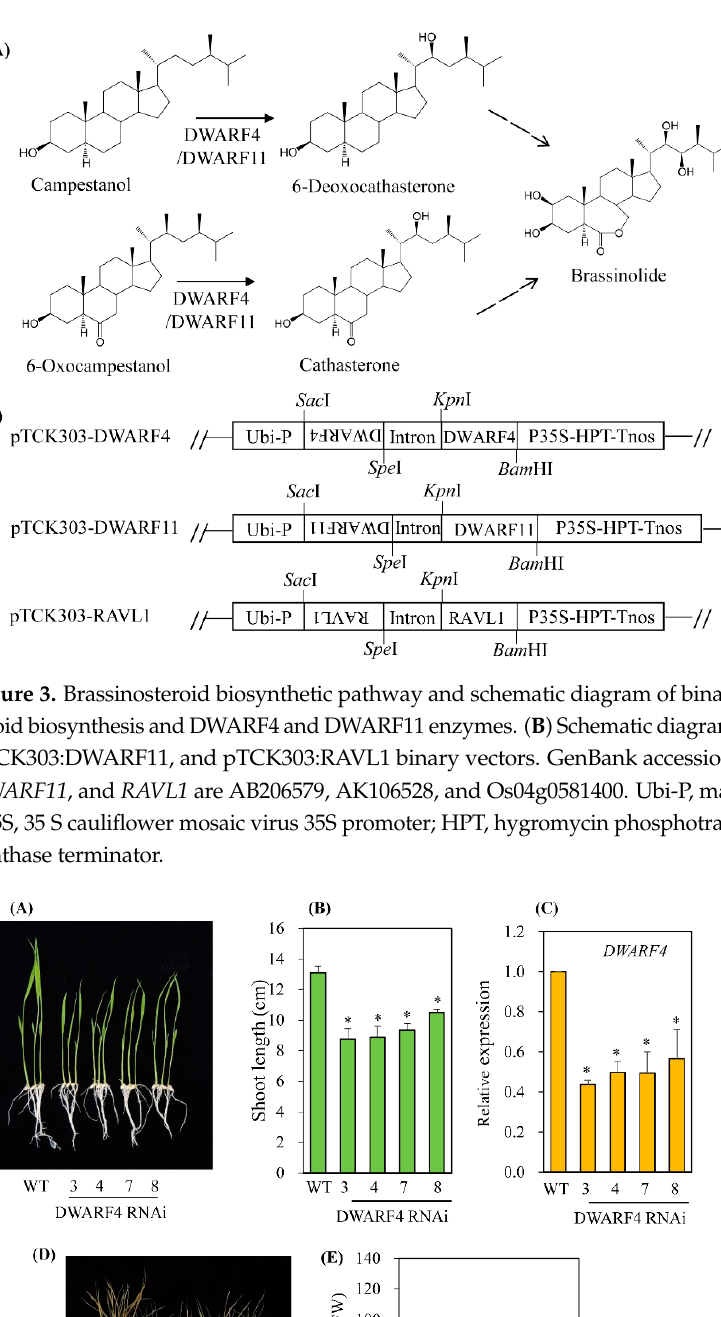
Figure 5. Generation of DWARF11- suppressed transgenic rice plants. ( A ) Phenotypes of 7-day-old wild- type (WT) and DWARF11 RNAi transgenic (T 2 ) rice seedlings. ( B ) Shoot length measurement. ( C ) Results of qRT-PCR analyses of WT and transgenic (T 2 ) lines. ( D ) Phenotypes of 7-day-old rice seedlings after cadmium treatment. ( E ) Melatonin levels of WT and transgenic lines. The 7-day-old rice seedlings were challenged with 0.5 mM cadmium for 3 days for quantification of melatonin. Asterisks (*) indicate signif- icant differences from the wild type ( p < 0.05), as determined by Tukey’s HSD post hoc tests.